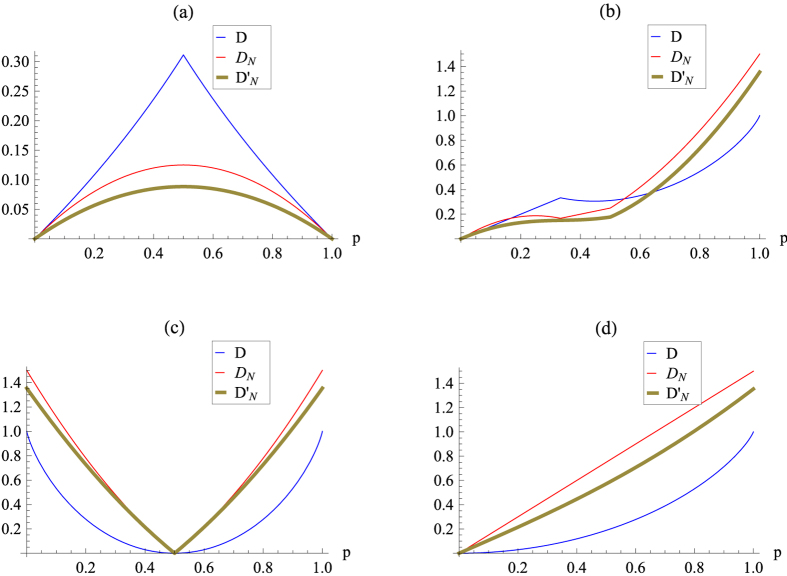
The measures D, DN and  as a function of p for (a) ρ1, (b) ρ2, (c) ρ3 and (d) ρ4.